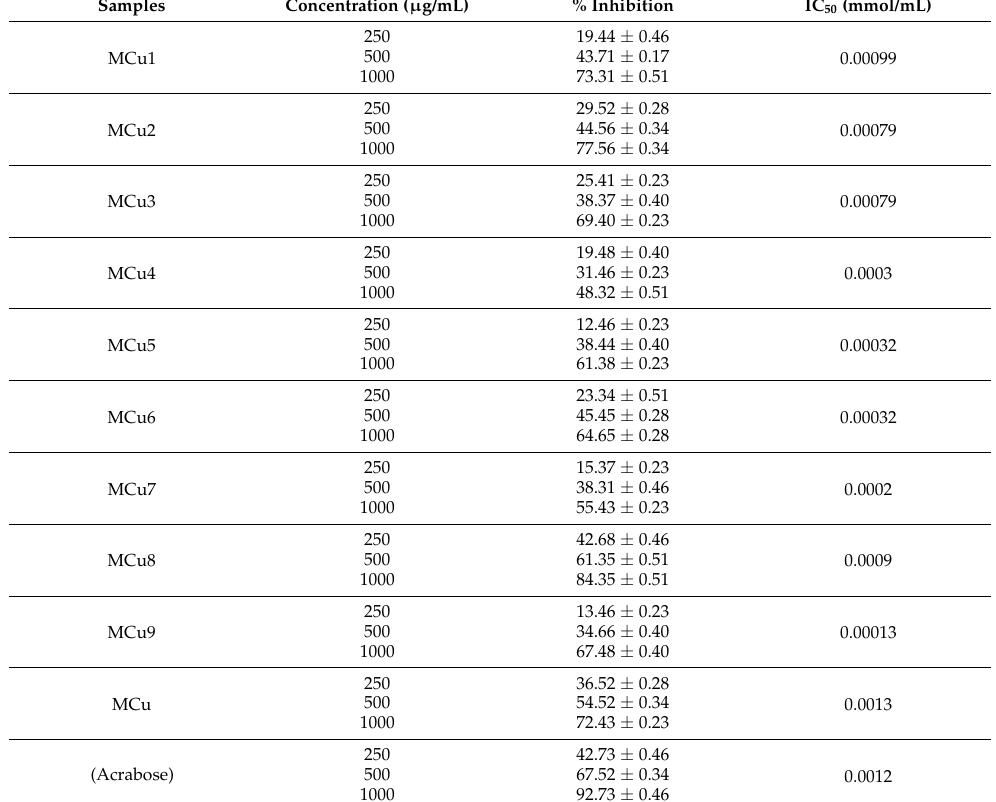
Table 8. α -Amylase activity of MCu1–MCu9.